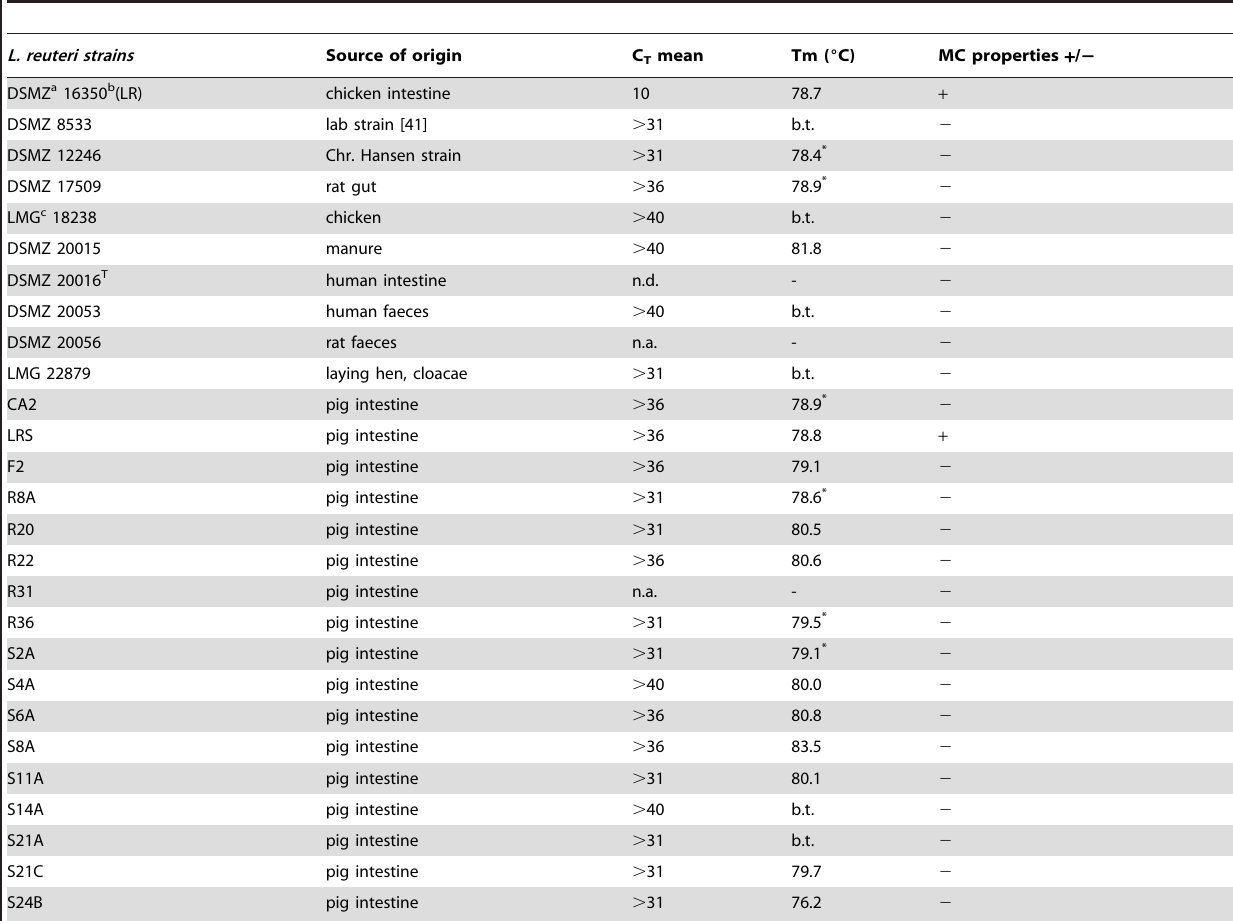
Table 1. L. reuteri (LR) qPCR specificity test (C T values and melting curve analysis) using non-target strains from various sources, purchased from culture collections and isolated from intestinal